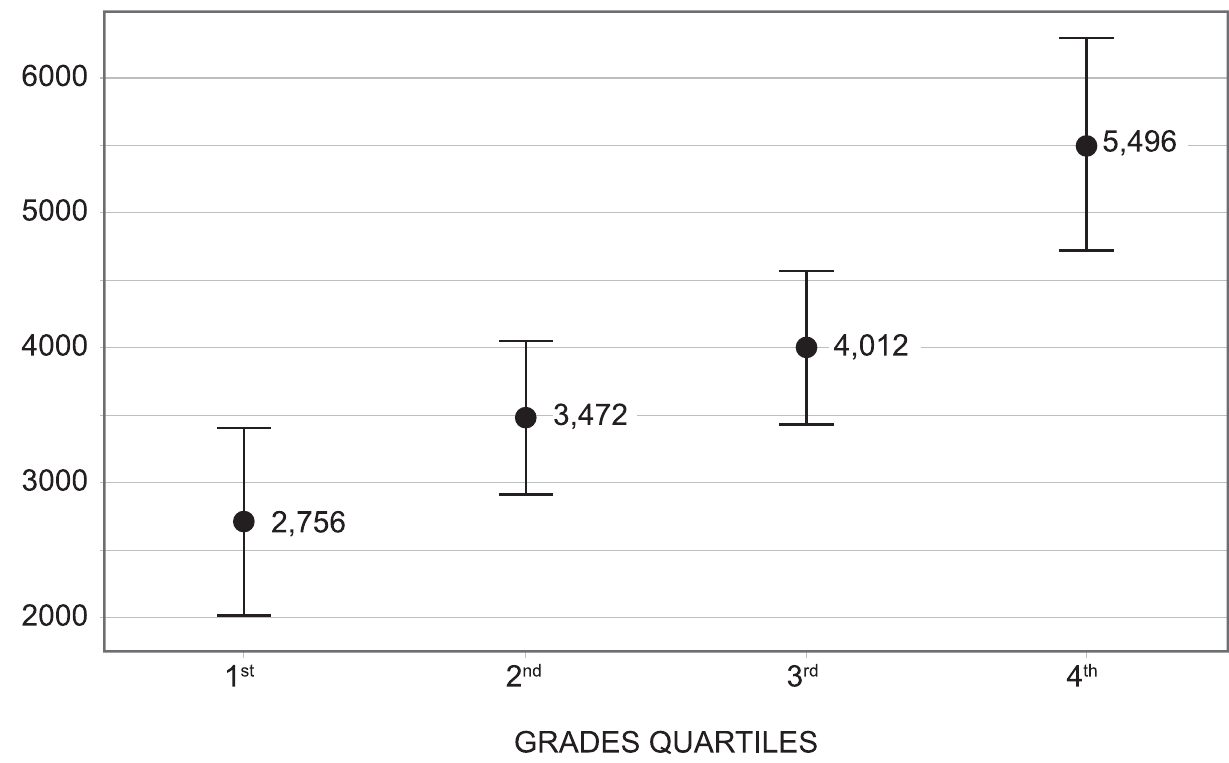
Fig 5. Confidence interval between minutes logged on during the rotation period and final grade (divided in